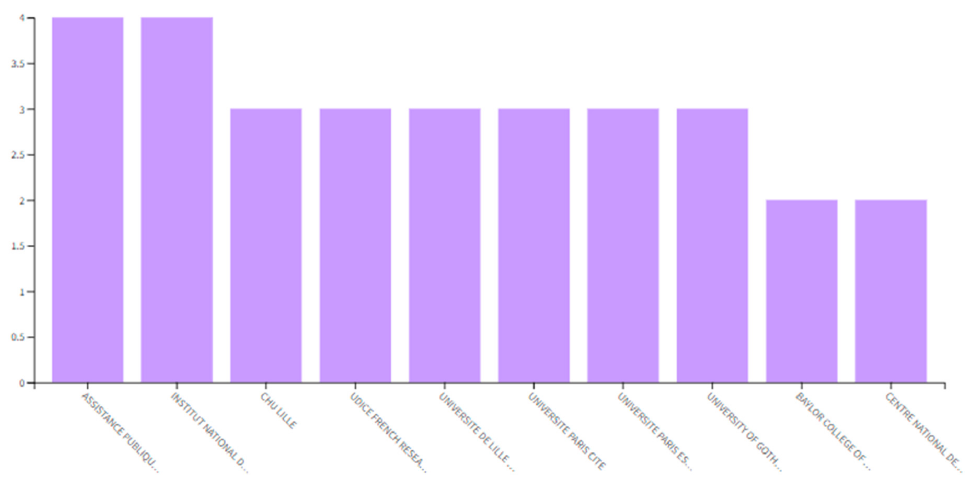
Figure 11. Institutions with the highest number of publications—Web of Science.